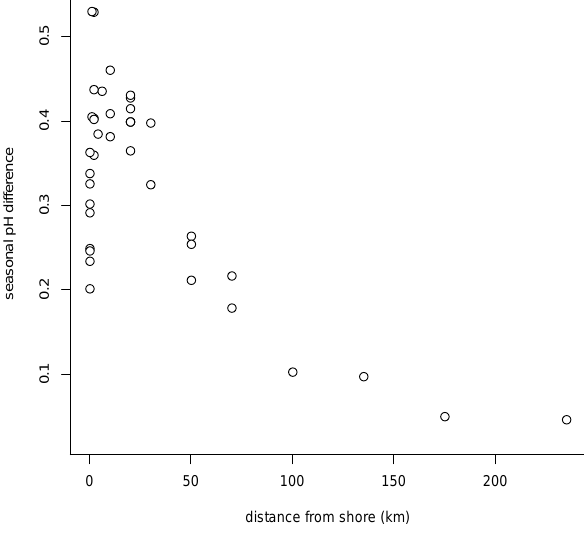
Fig. 7. Mean seasonal amplitudes at the North Sea stations as a function of distance from shore. Seasonal amplitudes were calcu- lated by subtracting values measured in January from those mea- sured in May, after detrending.